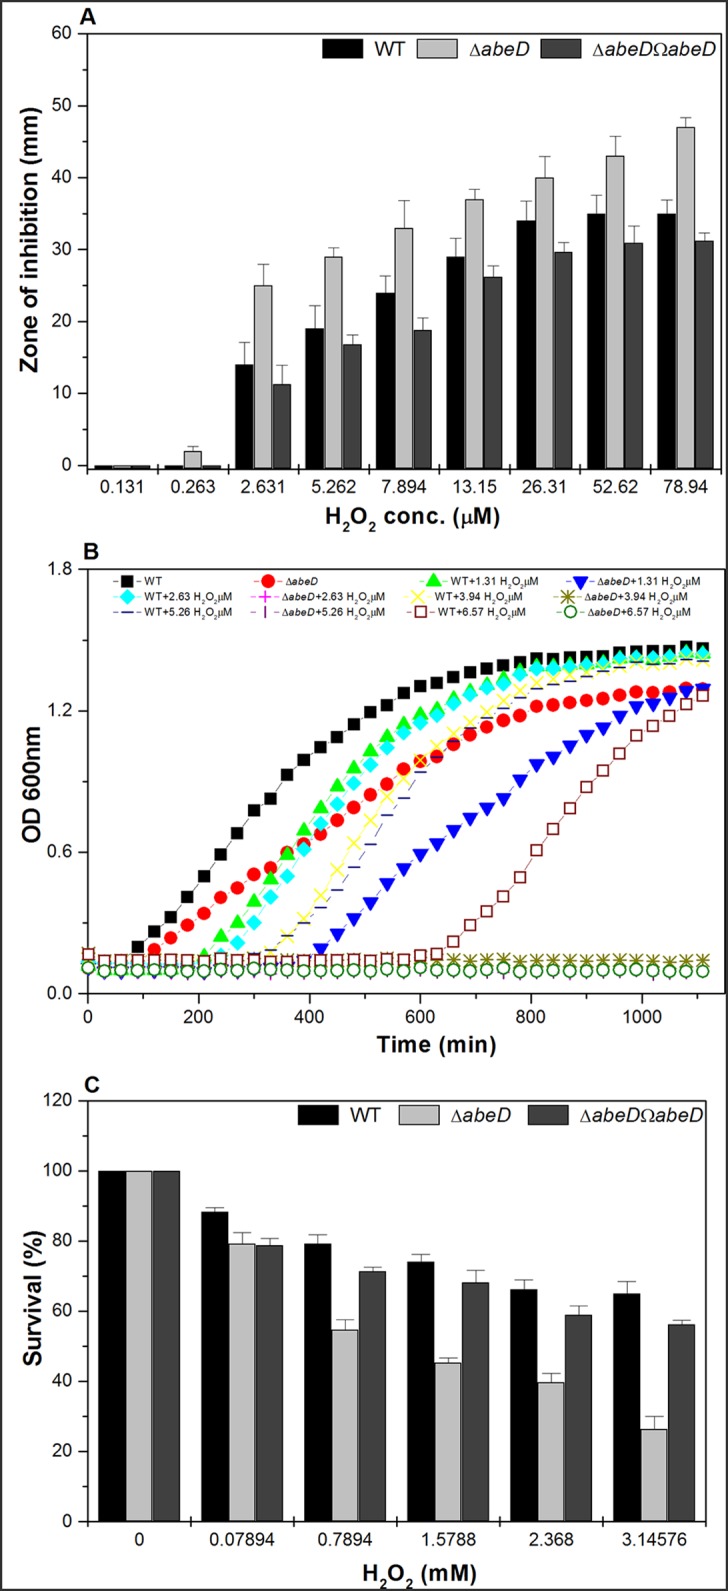
Hydrogen peroxide stress assays.A, The behavior of WT, ΔabeD and ΔabeDΩabeD strains. The ability of WT, ΔabeD to resist various levels of H2O2 was tabulated performing disc diffusion assay and ΔabeD remained sensitive to the challenges. B, The impact of various concentrations of H2O2 on the growth ability of WT and ΔabeD. The differences between WT and ΔabeD are statistically significant (P < 0.05) for all different H2O2 concentrations used. C, The survival ability of WT and ΔabeD towards varied concentrations of H2O2 was elucidated as described previously. The differences between WT and ΔabeD are statistically significant (P < 0.05) for all concentrations used.